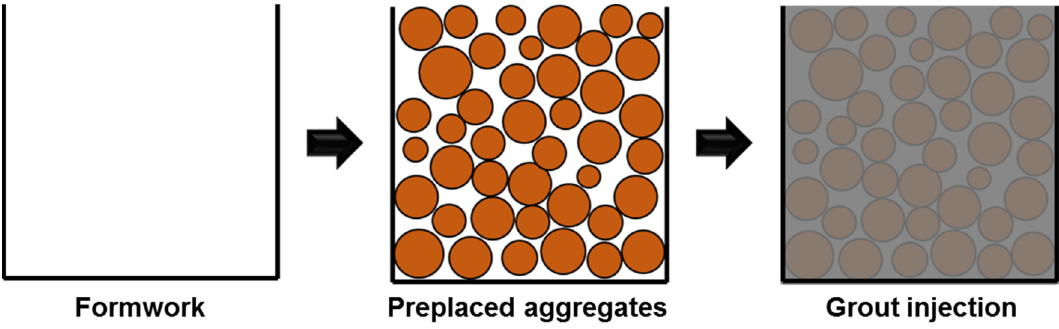
Figure 5. Illustration of the two-stage casting